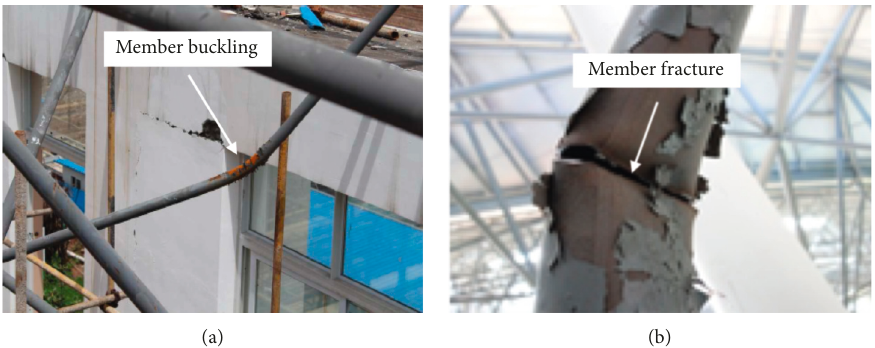
Figure 1: Destruction of spatial grid structure under severe earthquake.